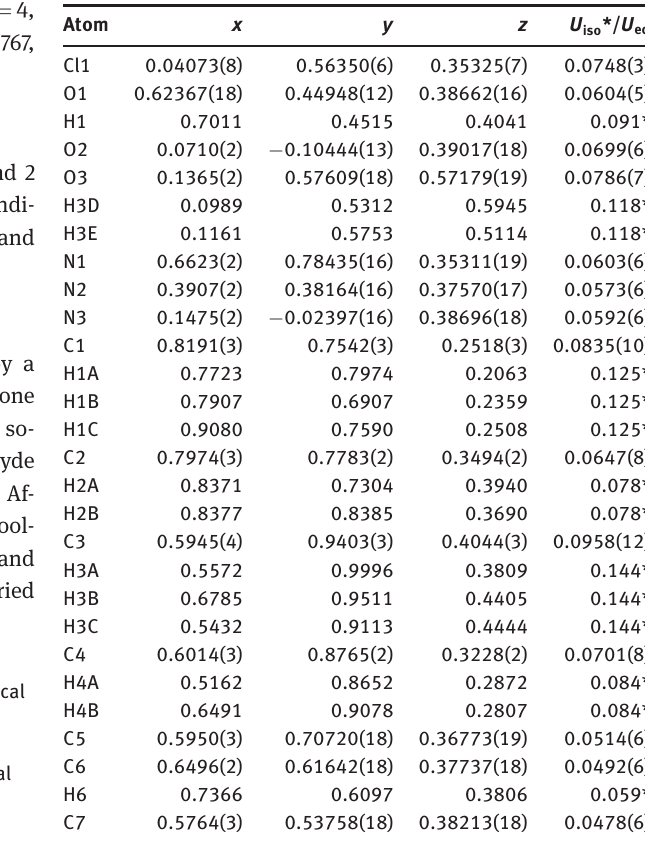
Table 2: Fractional atomic coordinates and isotropic or equivalent isotropic displacement parameters (Å 2